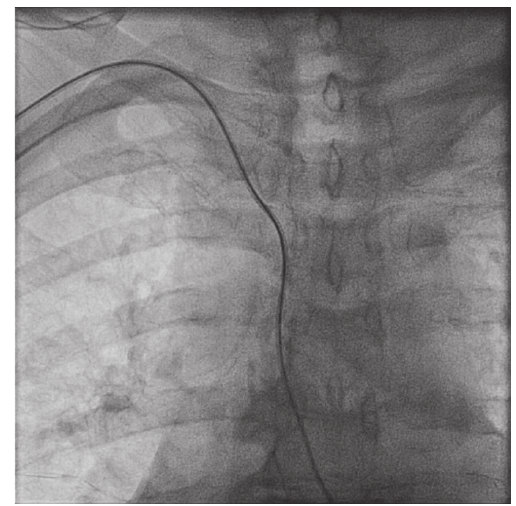
Figure 2: Advancement of the catheter along the Guidewire in the brachiocephalic artery and